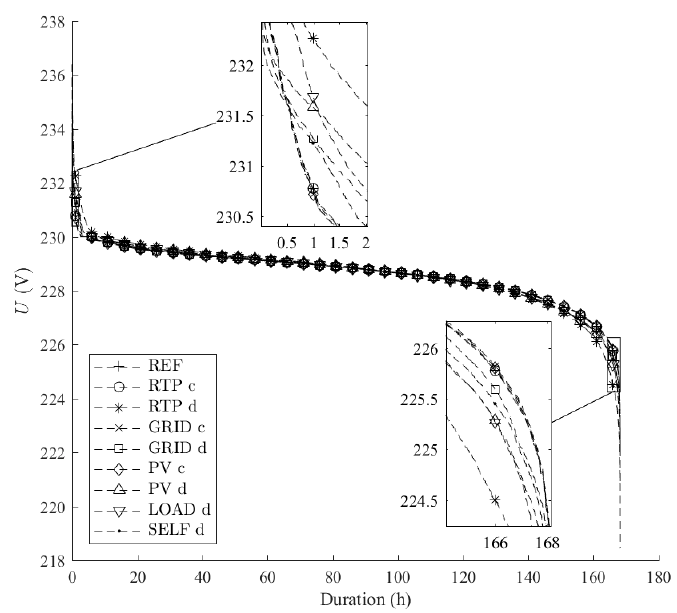
Figure 4. Power duration curve for a single, central storage (c) and multiple, distributed storages (d) driven by different incentives.